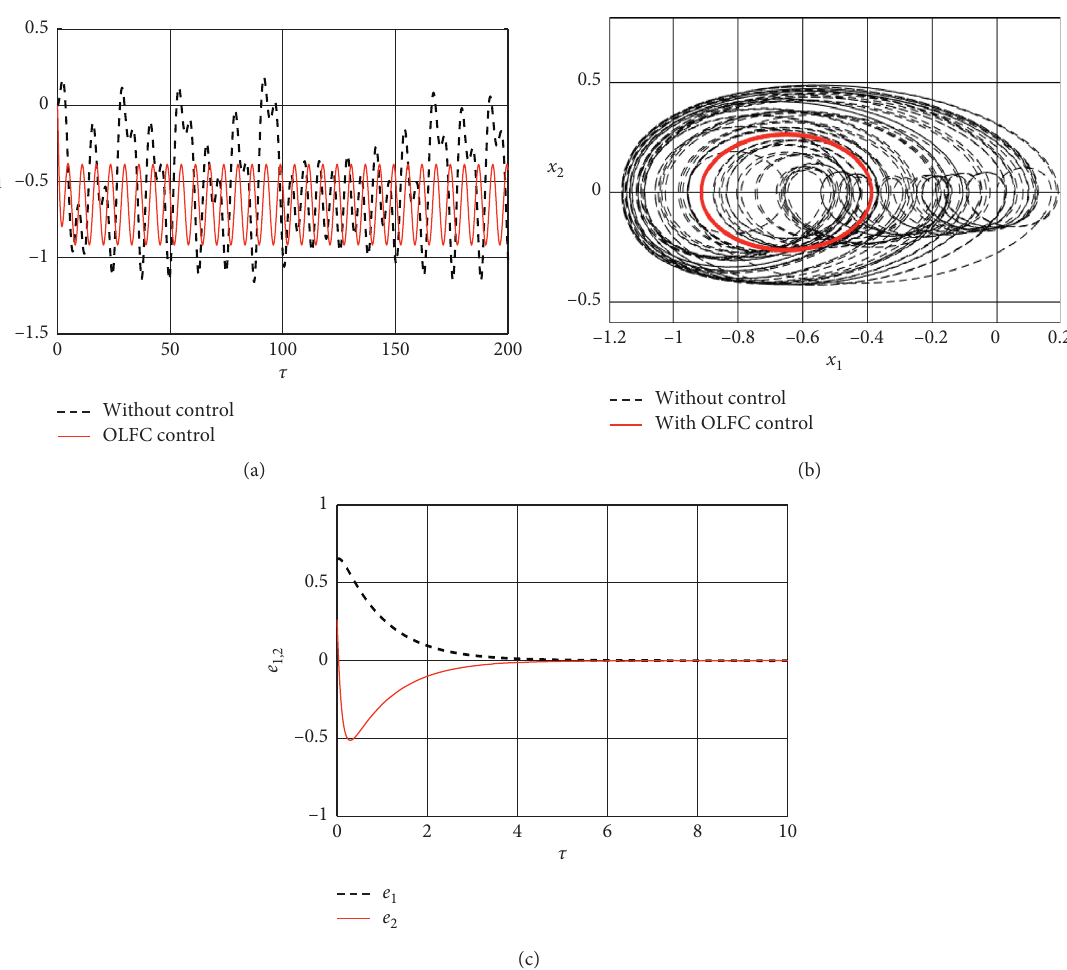
� x − 􏽥 x � x − 􏽥 x and e 1 1 1 2 2 2